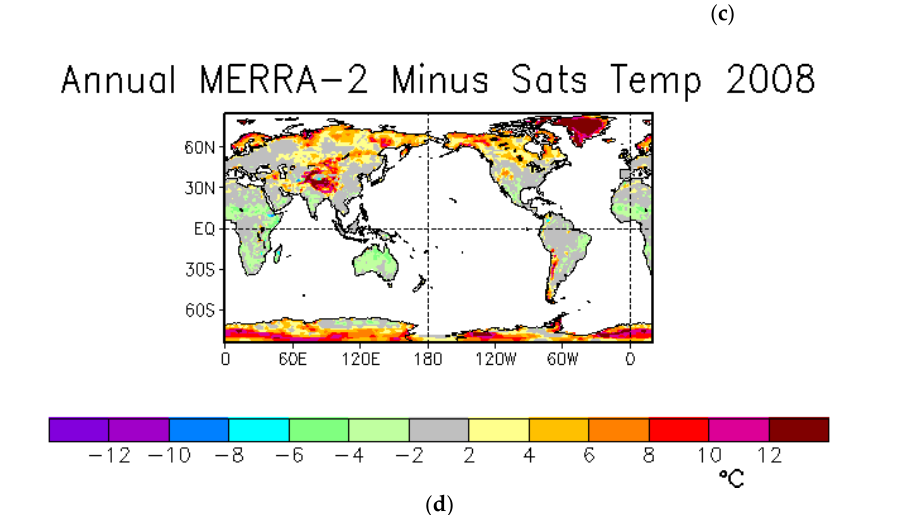
Figure 7. Annual surface temperature for 2008 for MERRA-2 ( a ), HBC—all satellites ( b ), each individual satellite ( c ), and mERRA—Minus all satellites ( d ).